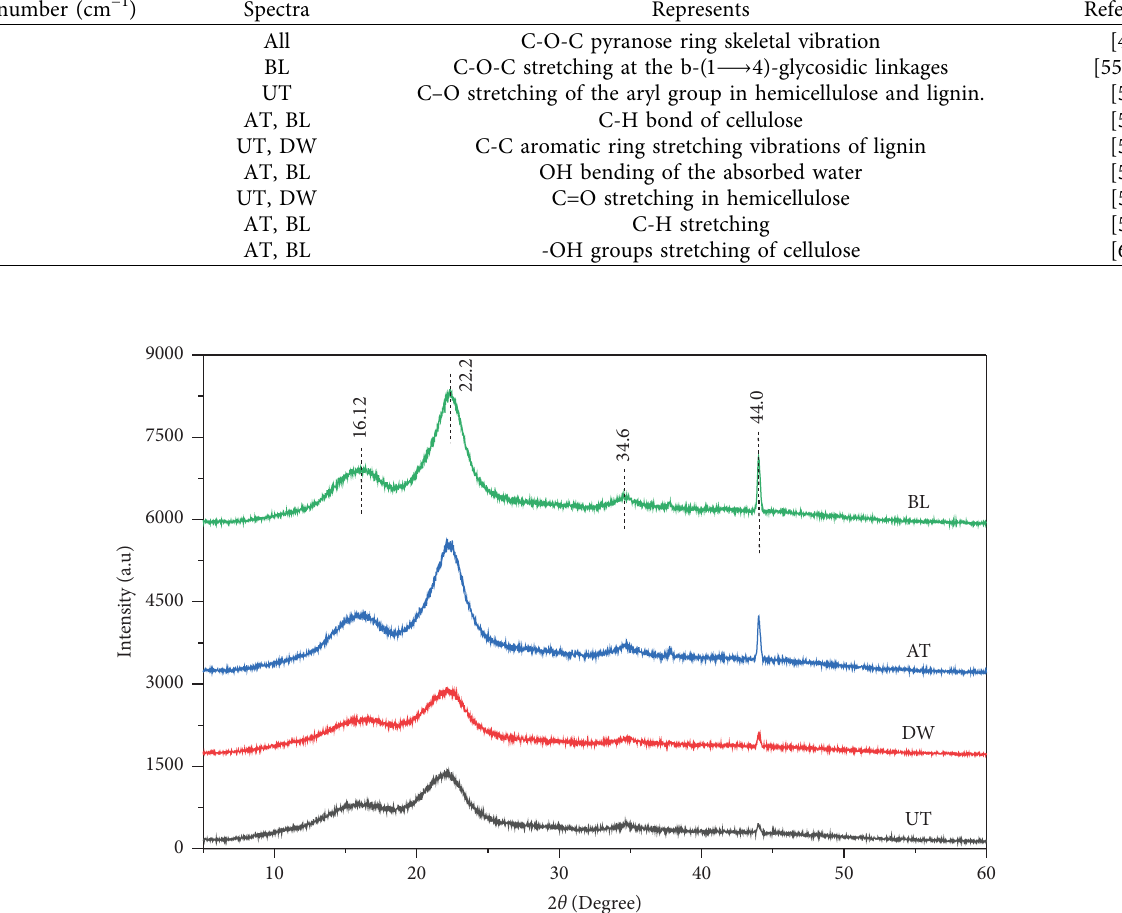
Figure 5: X-ray difraction pattern of untreated (UT), dewaxed (DW), alkali-treated (AT), and bleached (BL) sample of outer skin isolated cofee husk.